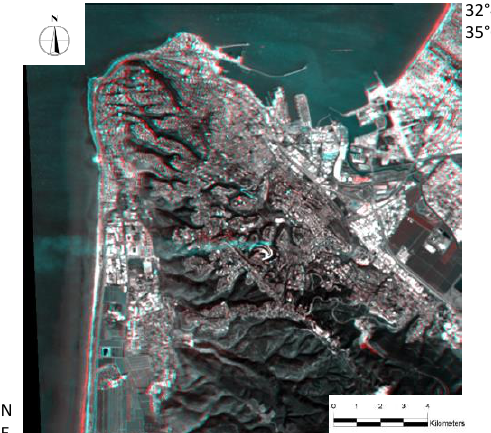
Figure 2. Change detection thematic map calculated by Landsat OLS8 multispectral pan-sharpen bands between day number 289 and day number 329 (during the fire event in Haifa)